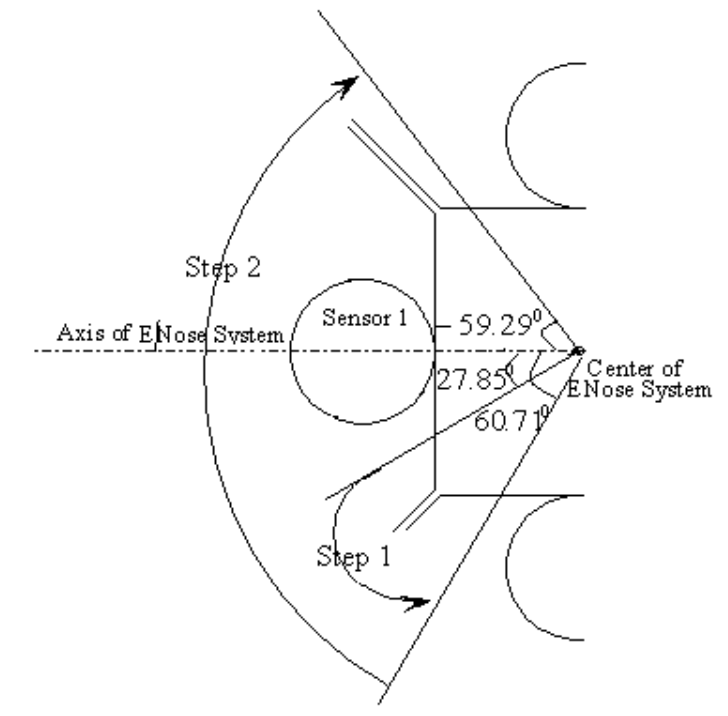
Figure 11 . Tracking dynamic source